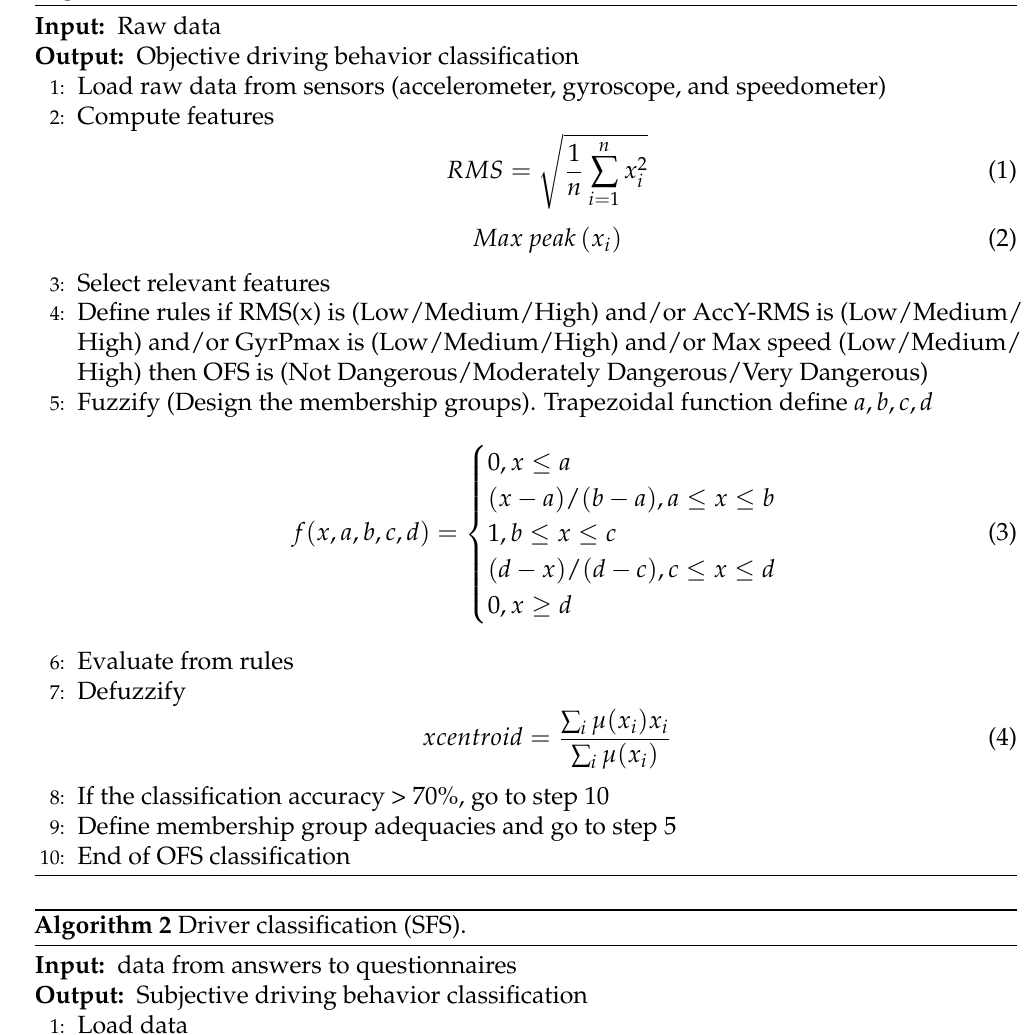
Algorithm 1 Driver classification (OFS).